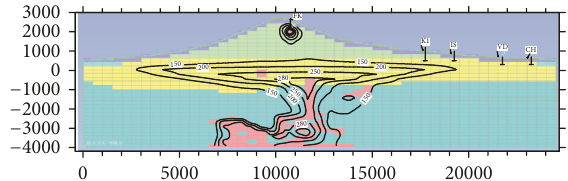
Figure 6: Model grid, zonation, and boundary conditions (Base, NQ1, Volca, Dike, Fixe 1, Fixe 2, see Table 4), and thermal features assignedas“wellsondeliverability”(FK,K1,IS,VD,CH,seeTable 1). This model position corresponds to the vertical cross-sectional AB showninFigure 2.Horizontalandverticalaxesarelabeledinmeters.